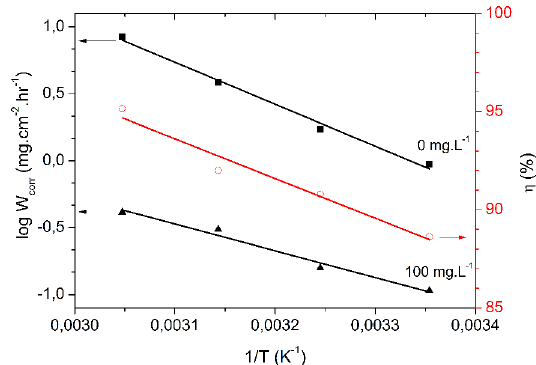
Figure 7. Arrhenius plot for the C-steel corrosion rate in 1.0 mol∙L -1 HCl in absence and presence of 100 mg∙L -1 of ethanolic Aniba canelilla